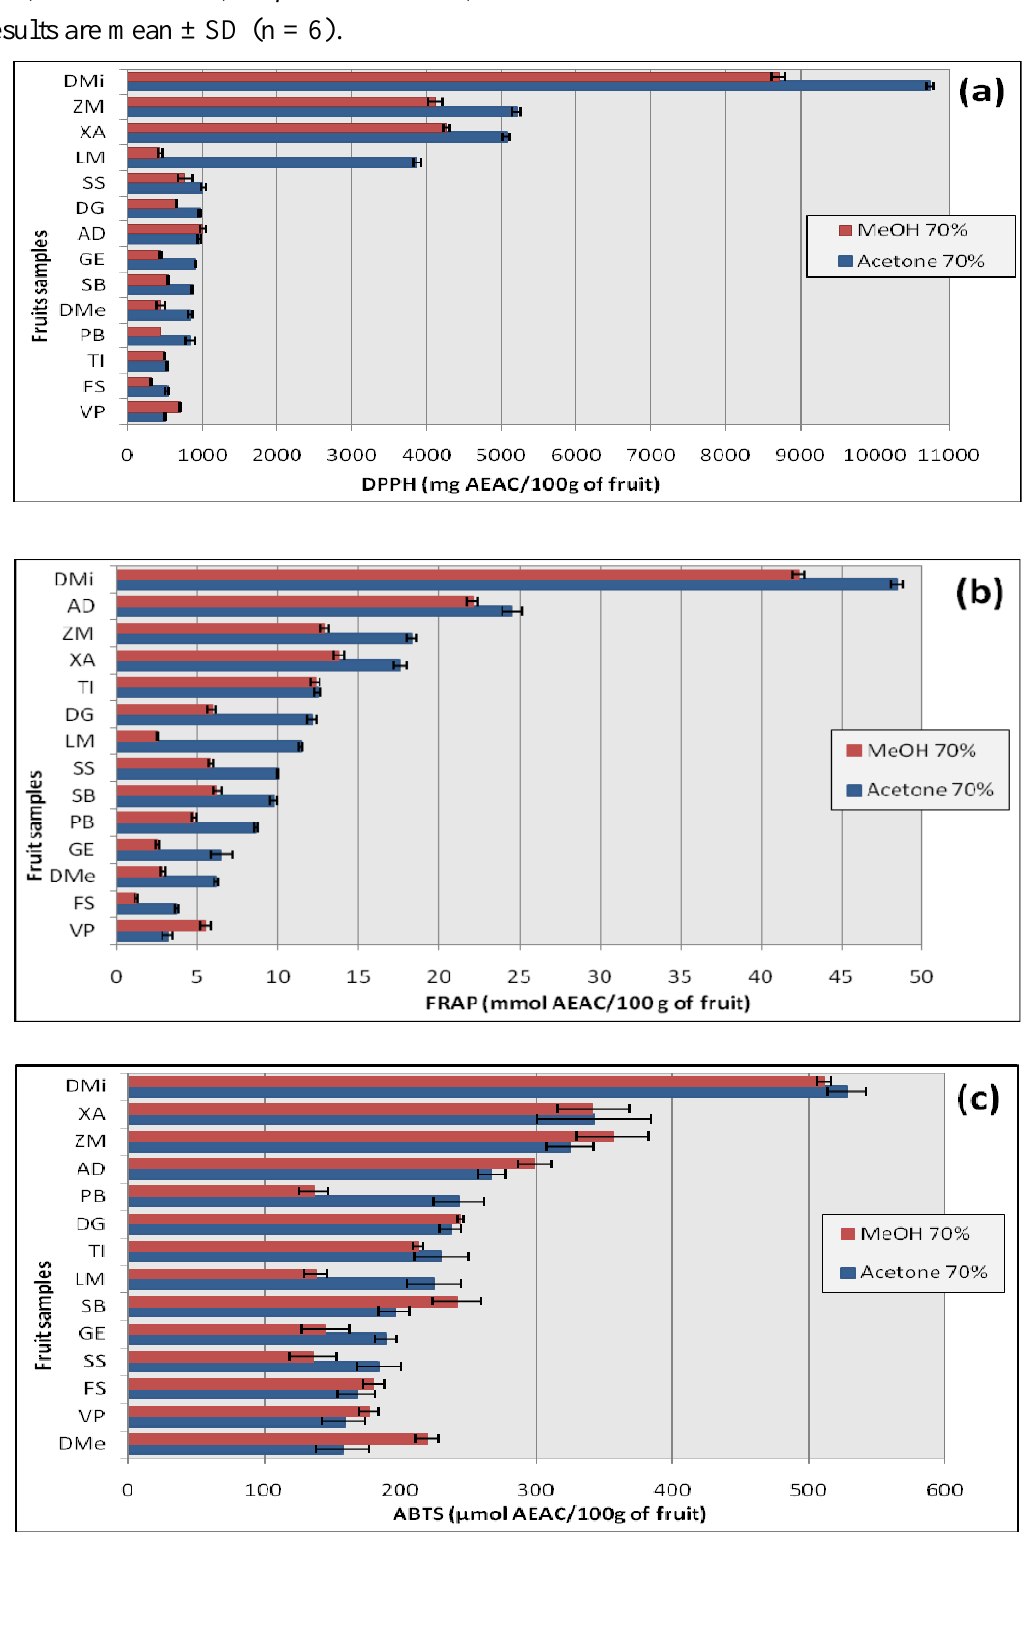
Figure 1. Antioxidant activities obtained using the DPPH (a), FRAP (b) and ABTS (c) methods on fourteen fruit extracts (MeOH and Acetone)